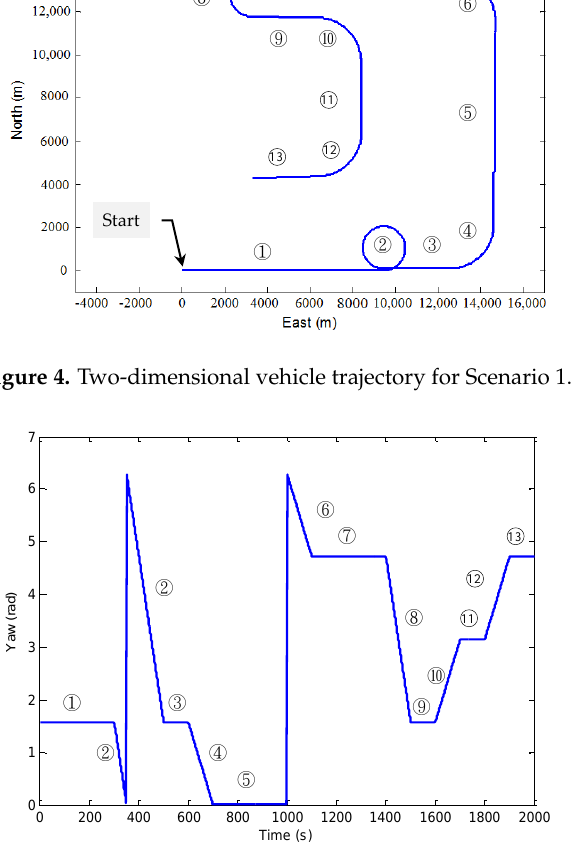
Figure 5. The yaw angle of the vehicle for two-dimensional simulation. Table 3. Description of the vehicle motion for Scenario 1.